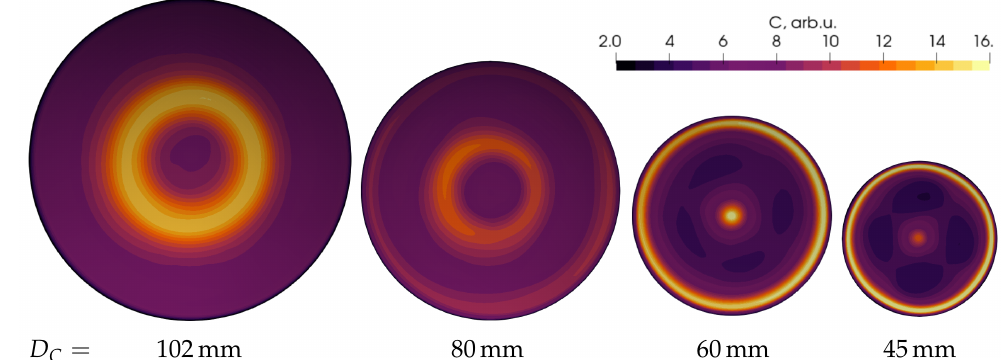
Figure 14. The time-averaged carbon concentration on the crystallization interface, simulated for the cone phase ( D C < 102mm) and cylindrical phase ( D C = 102mm).